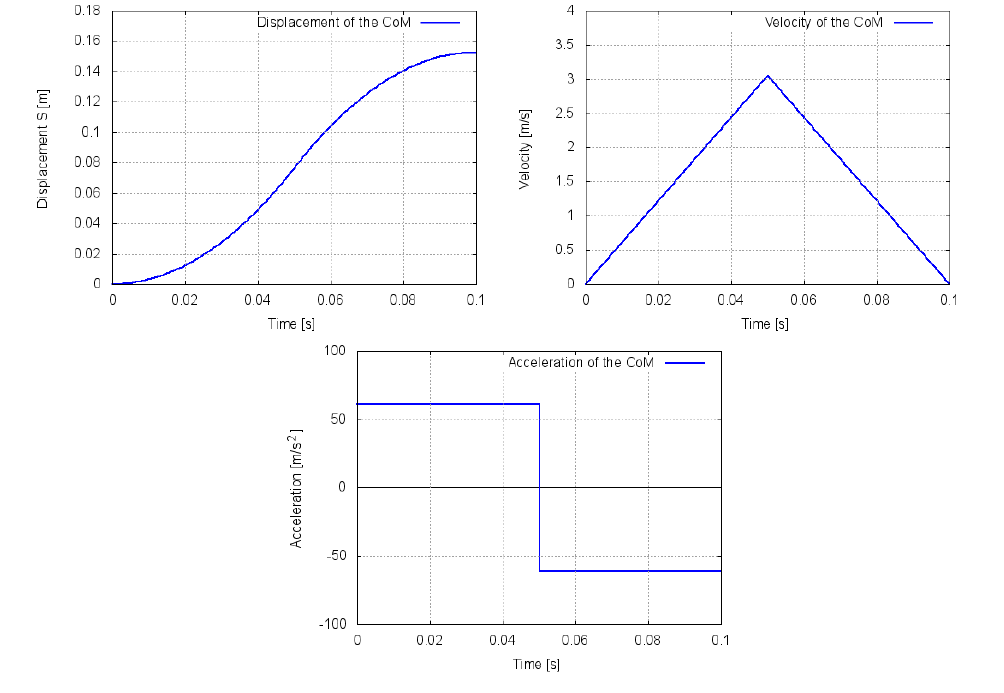
Figure 5. The “bang-bang” profile imposed to the global CoM of the